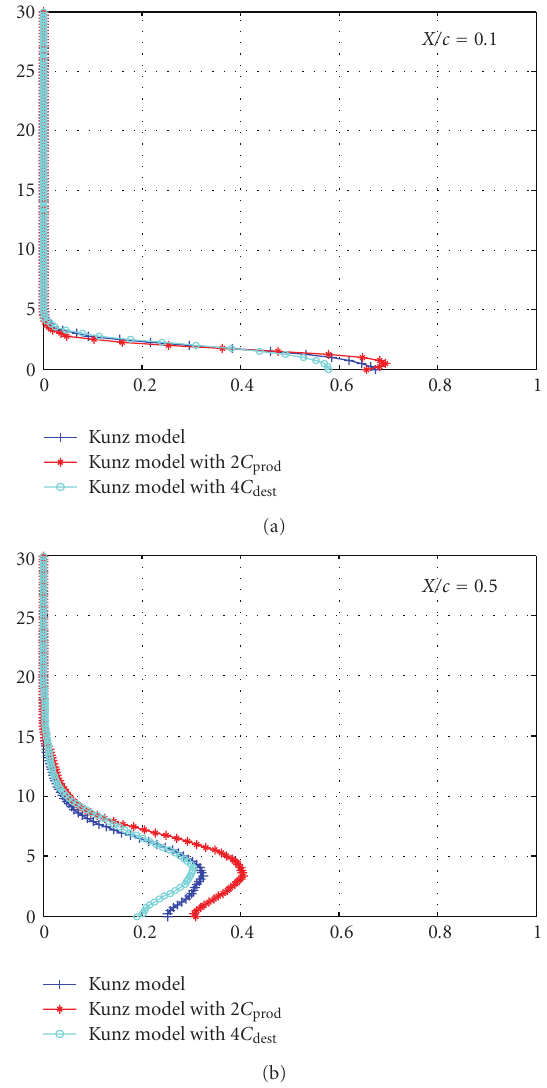
Figure 12: Void fraction distributions ( L/c = 0 . 8, V ref = 6 m/s).